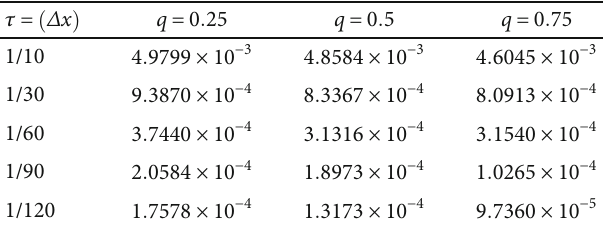
Table 2: The numerical results of the proposed scheme for Example 6 at T = 1 : 0 .